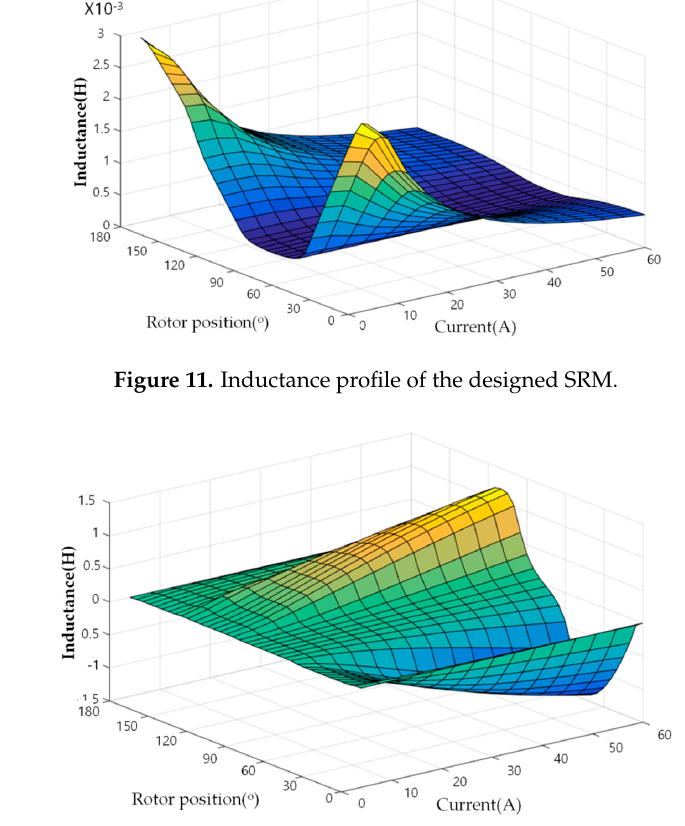
Figure 12. Torque profile of the designed SRM.